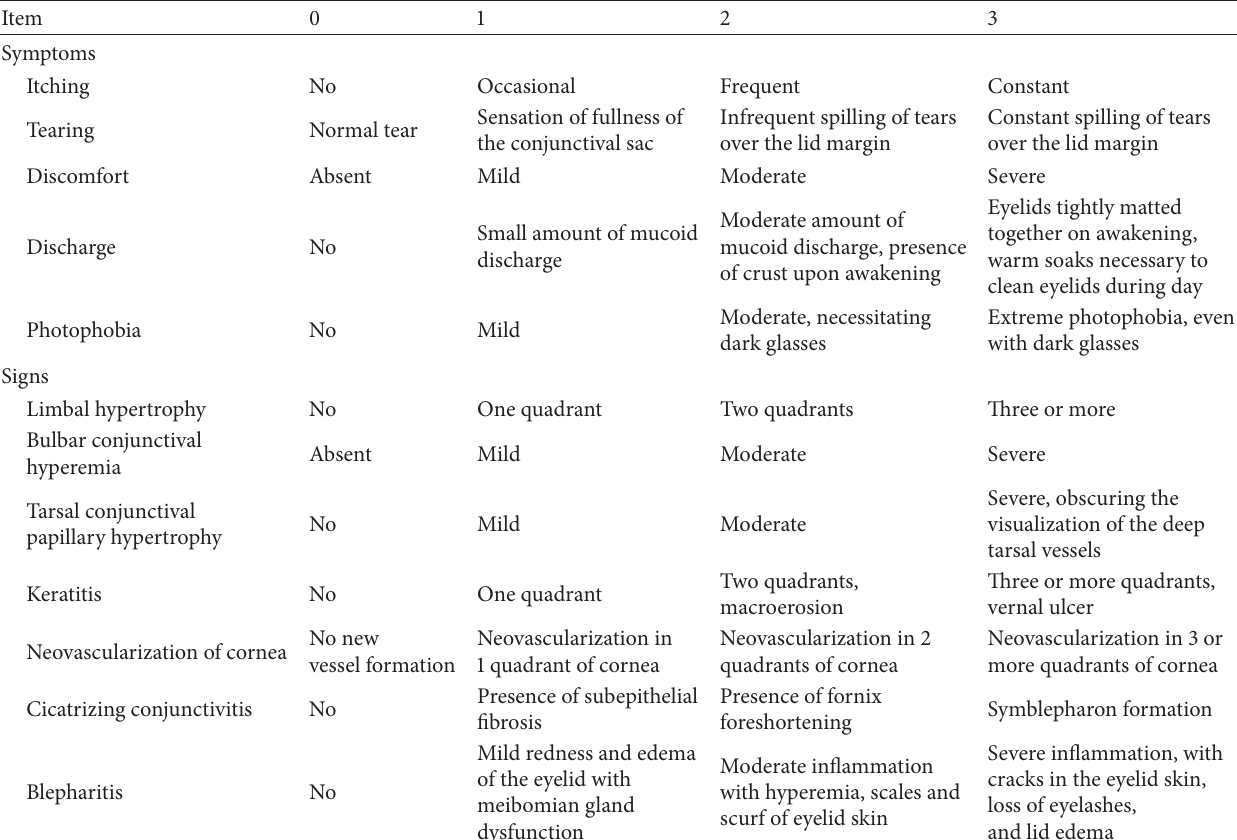
Table 1: Grading of symptoms and signs of allergic